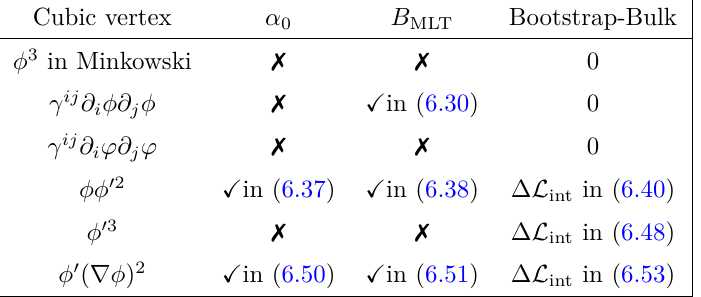
Table 2 . Here we summarise the main features of various 4 -point exchange functions induced by two copies of the cubic vertex given in the first column and computed with our three-step procedure. Unless stated otherwise, the background geometry is de